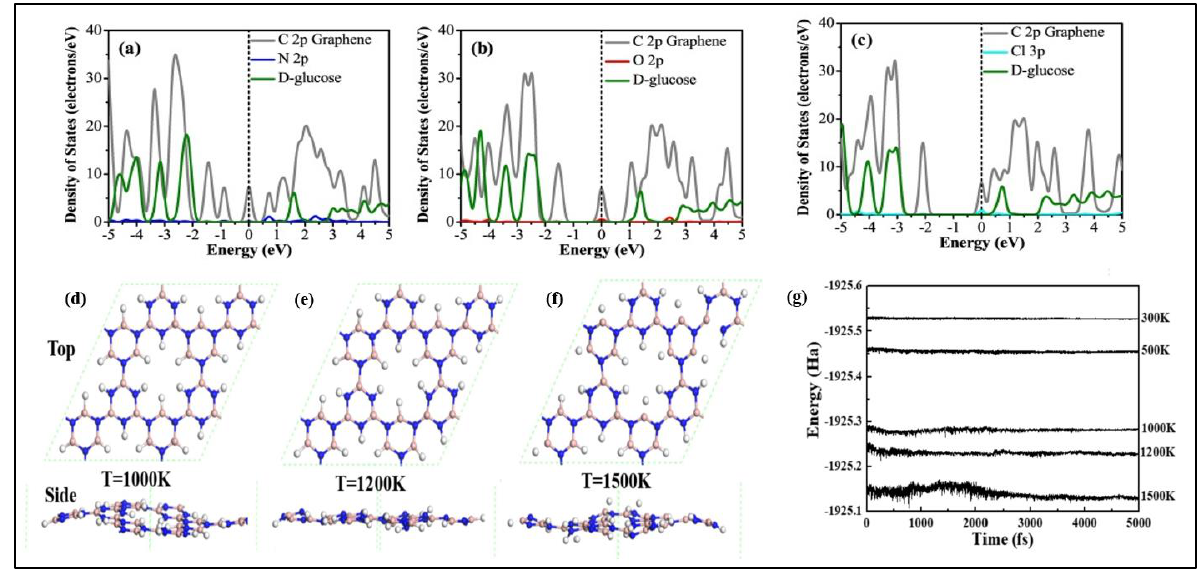
Figure 15. PDOS plots of D -glucose molecule adsorption on the ( a ) N-, ( b ) O-, and ( c ) Cl- decorated HGr, Reprinted from Ref. [184]. ( d ) 1000 K, ( e ) 1200 K, and ( f ) 1500 K after five ps of the Molecular Dynamic simulations. ( g ) the total energy variations of the B 6 N 6 H 6 monolayer during the MD simulations at T = 300, 500, 1000, 1200, and 1500 K, Reprinted with permission from Ref. [201].